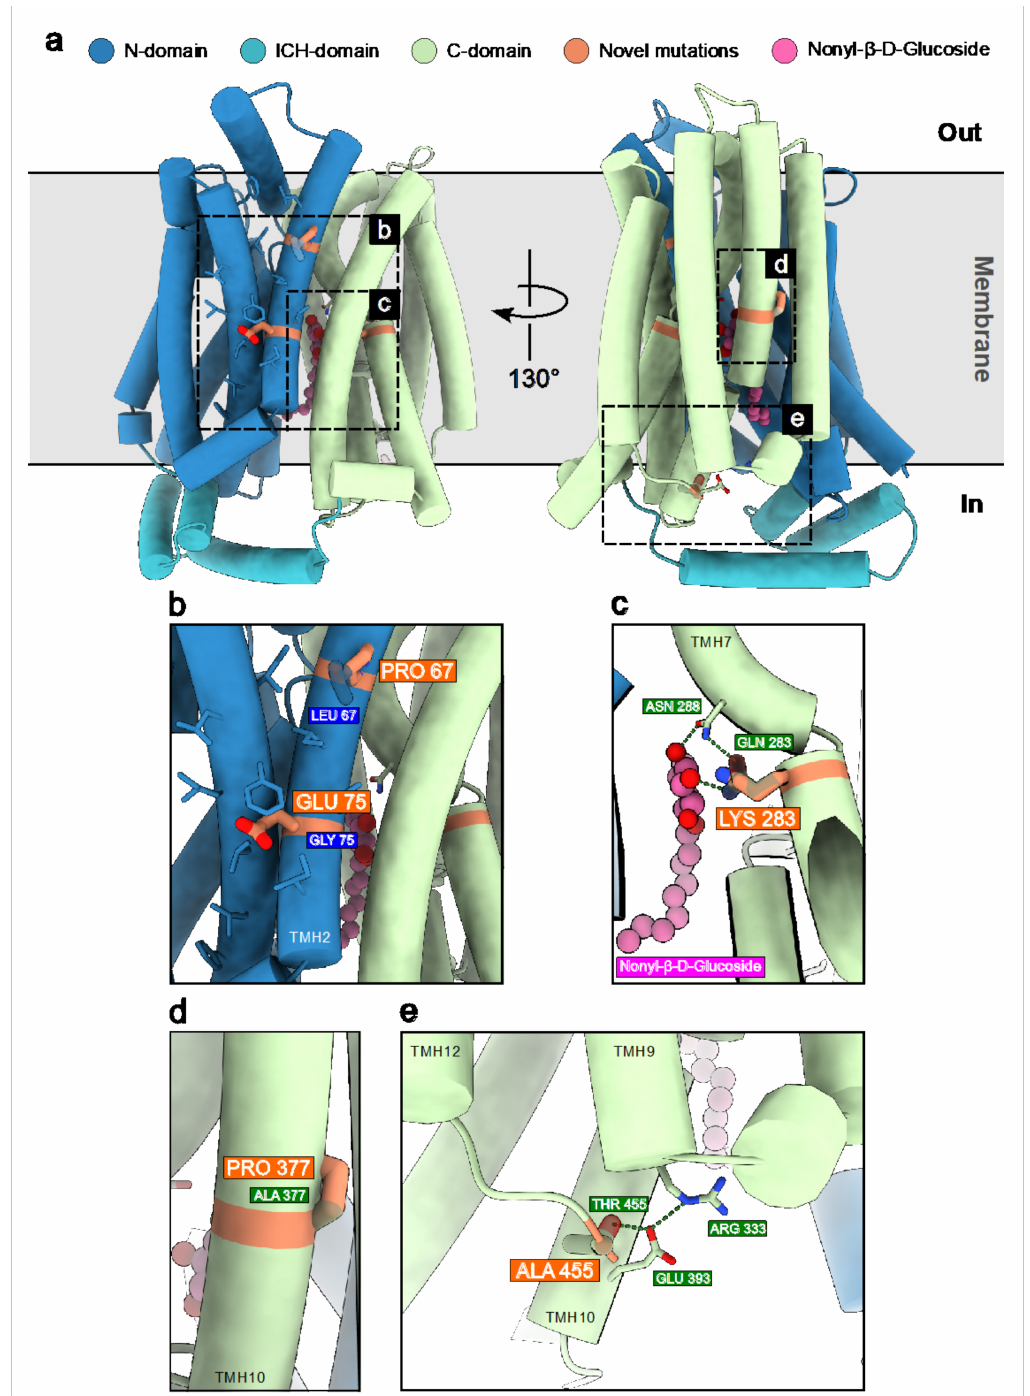
Figure 4. Novel disease-related mutations mapped on the structure of GLUT1. ( a ) X-ray structure of human GLUT1 (PDB ID: 6THA) bound to Nonyl- β -D-Glucoside via its glucose head group. Novel disease-related mutations identified in this study are depicted in orange and superimposed on their corresponding wild-type residues. ( b ), Mutations Leu67Pro and Gly75Glu on transmembrane helix 2 (TMH2) could disrupt the α -helical architecture and the hydrophobicity of the region, respec- tively. ( c ) Gln283Lys could hamper the hydrogen bond network that stabilizes glucose binding. ( d ) Ala377Pro could destabilize the α -helical architecture of TMH10. ( e ). Thr455Ala potentially breaks the hydrogen bond network between residues on TMH9, TMH10 and TMH12, possibly reducing the stability and rigidity of the C-terminal domain of